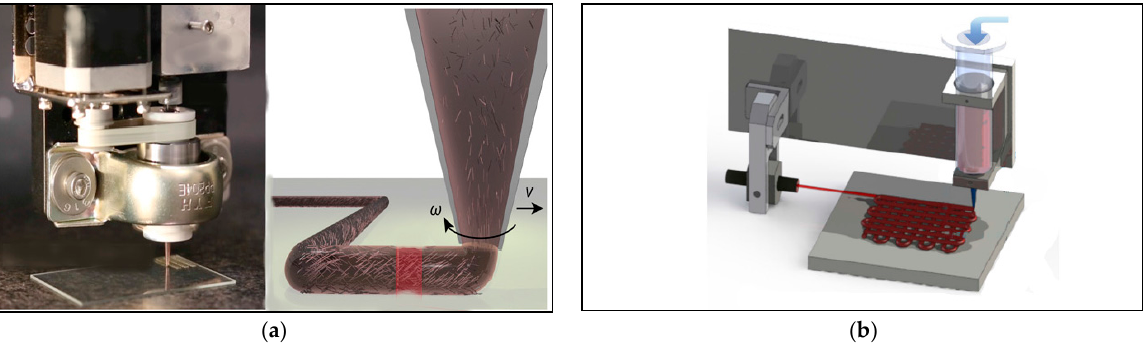
Figure 3. 3D printer auxiliary equipment. ( a ) Rotating auxiliary devices [24]; ( b ) Laser auxiliary devices [23]. devices